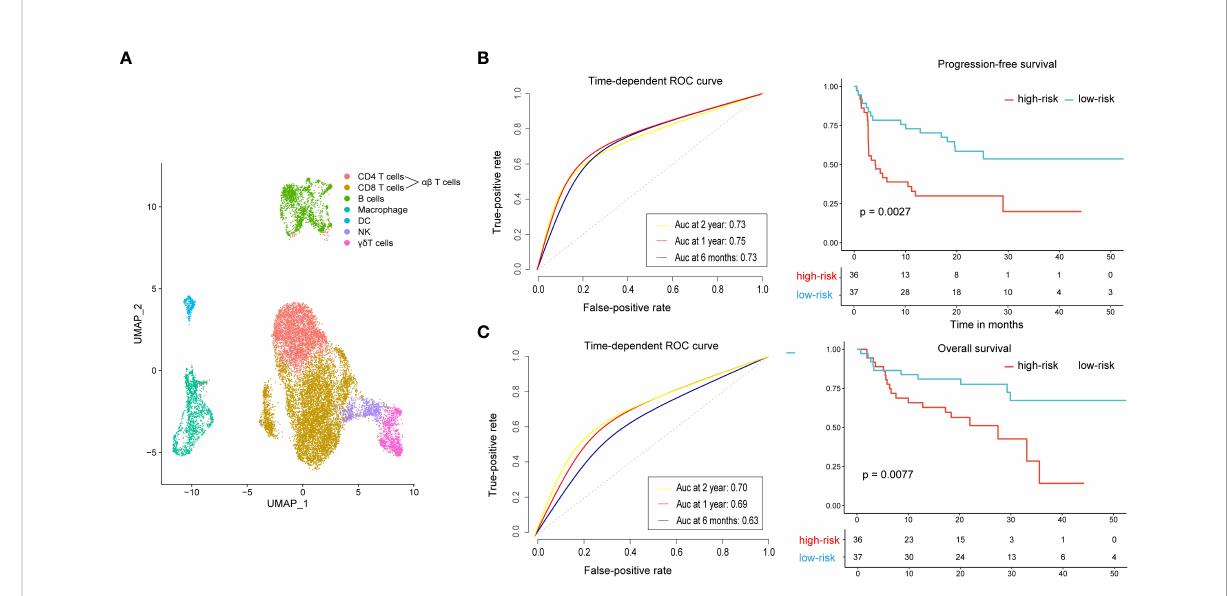
FIGURE 5 Extended analysis of the four-immune cell-subset gene signature on an independent dataset. (A) UMAP displays all immune cells collected in the GEO cohort. (B) Time-dependent ROC curves and Kaplan – Meier survival curves of progression-free survival. (C) Time-dependent ROC curves and Kaplan – Meier survival curves of overall survival. To assess prognostic accuracy, we used AUCs at 0.5, 1, and 2 years and calculated P values using the log-rank test. ROC, receiver operator characteristic; AUC, area under the